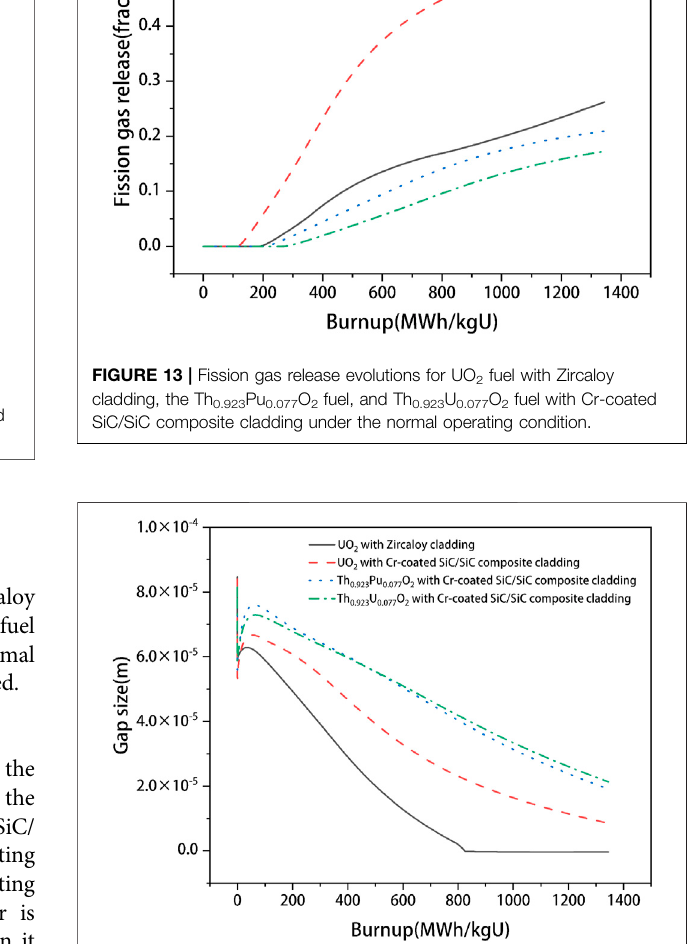
FIGURE 14 | Gap size evolutions for the UO 2 fuel with Zircaloy cladding, the